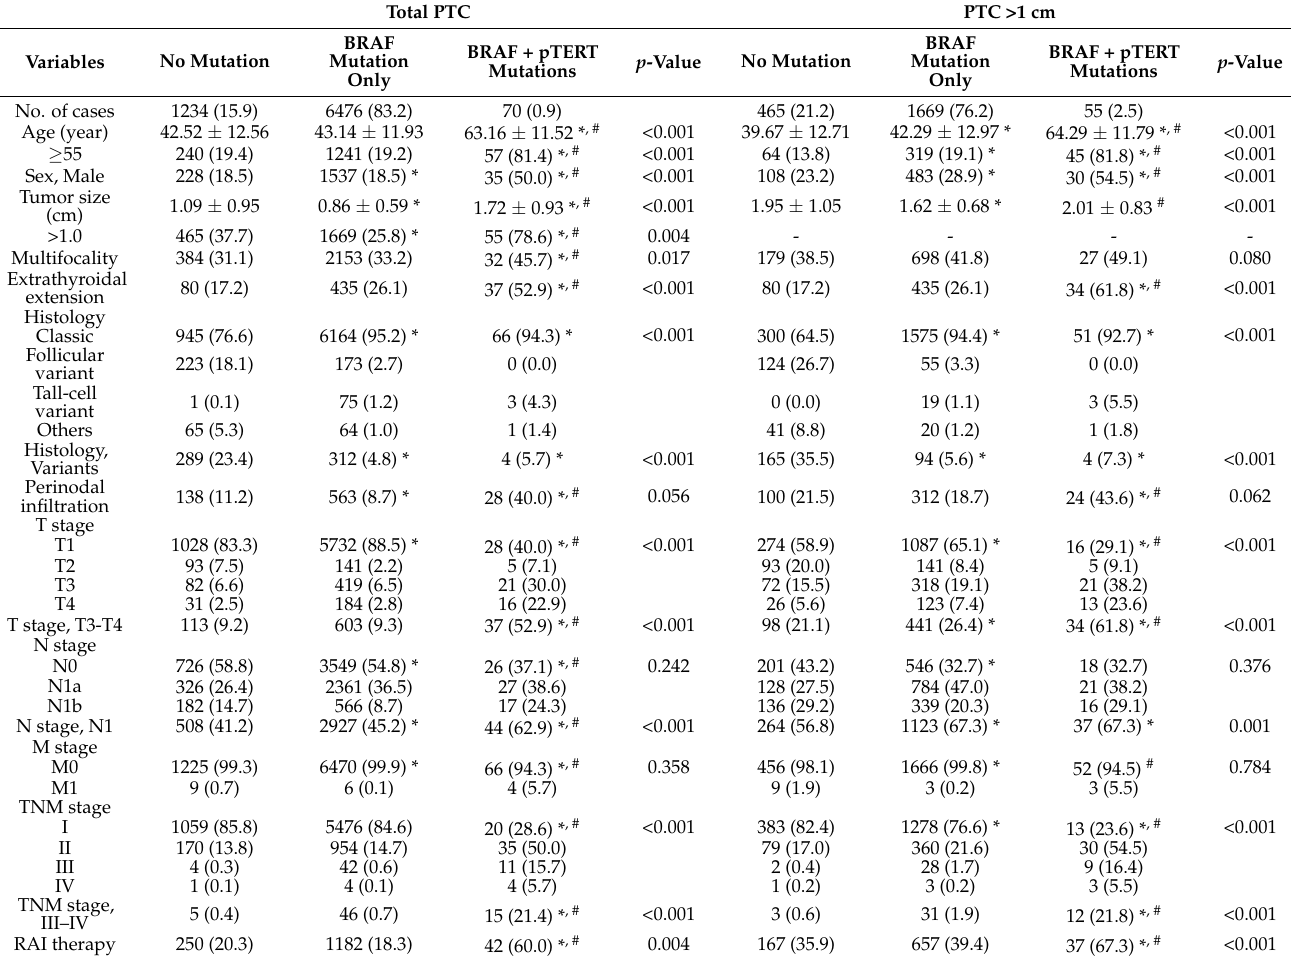
Table 4. The impact of both BRAF and TERT promoter mutations on clinicopathologic features of PTC in comparison with no mutation and BRAF mutation